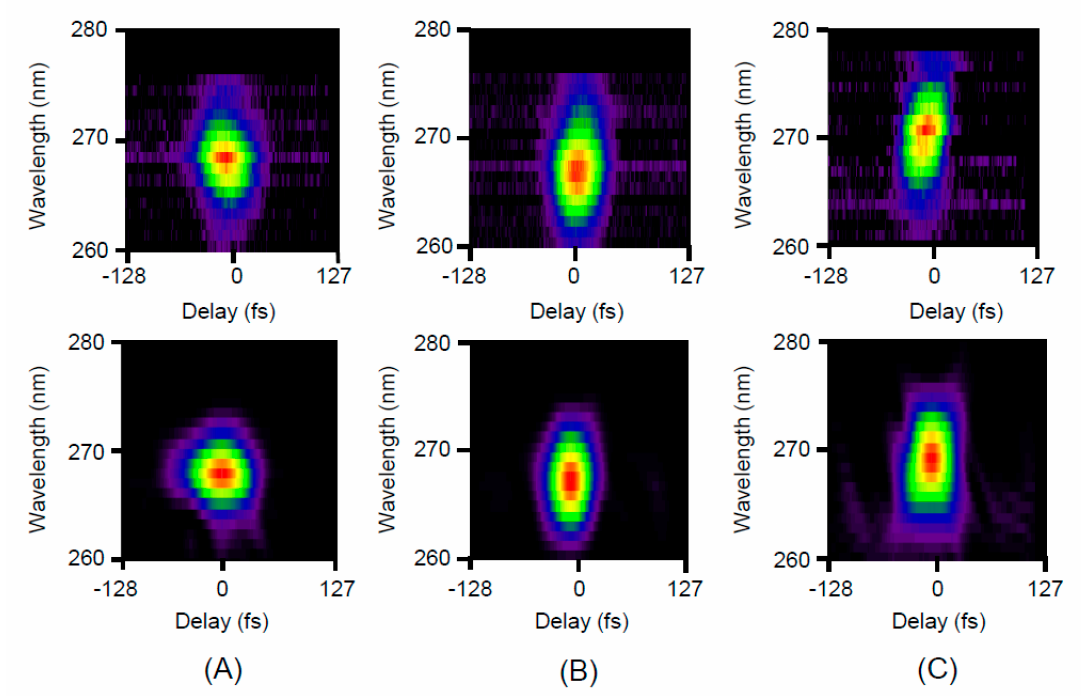
Figure 5. THG-FROG traces obtained for ( A ) negatively-chirped ( B ) FTL ( C ) positively-chirped pulses. The chirp of the pulse was adjusted by changing the position of the grating in the compressor of the Ti:sapphire laser to the value, at which the energy of the THG pulse decreased to a half of the value obtained using the FTL pulse. Above, original traces; below, retrieved data. FROG error: ( A ) 0.6% ( B ) 0.6% ( C )